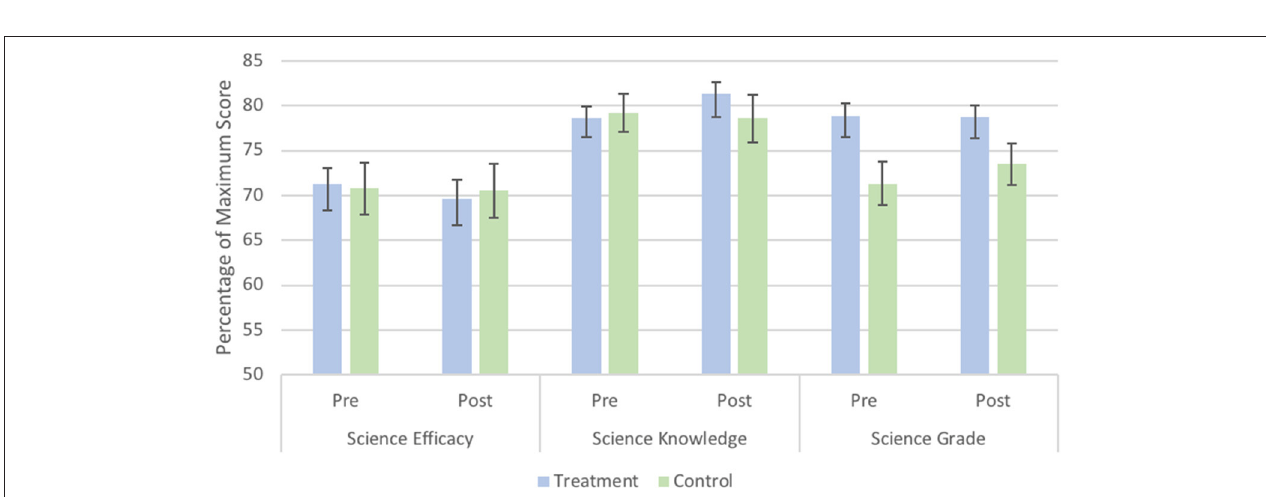
FIGURE 2 | Change in science efficacy, nature of science, and science grades among treatment and control groups. All measures are represented by percentages of the maximum score. Error bars represent standard errors.